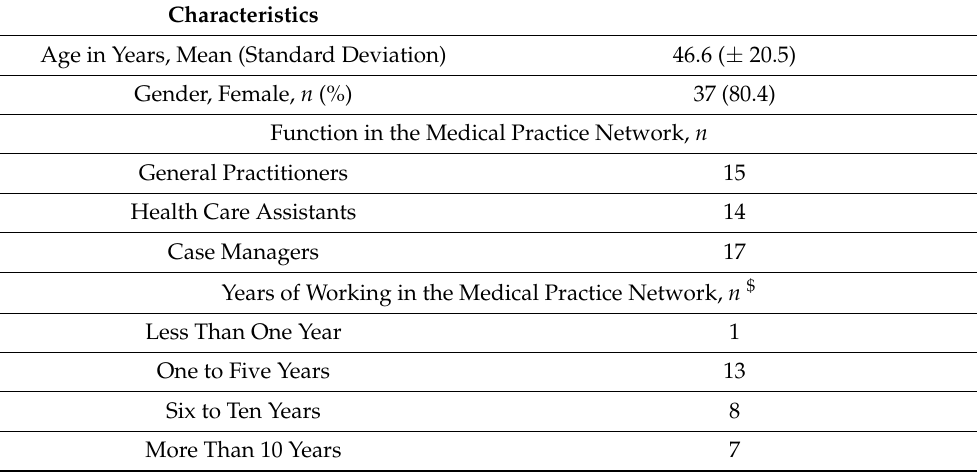
Table 1. Characteristics of study participants ( n = 46).